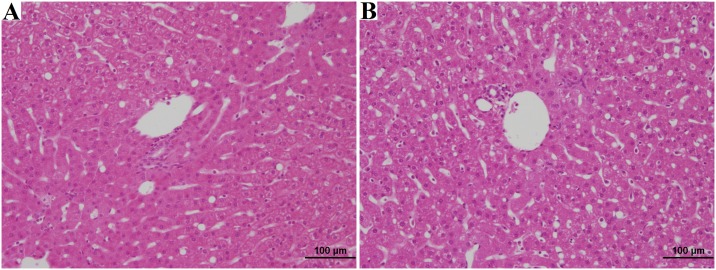
Liver H&E analysis.Biopsy A shows Liver H&E of naïve rhesus, age 15 years, diagnosed 5–10% macrovesicular fatty infiltrates, moderate/marked vacuolization. Biopsy B shows Liver H&E of brain dead rhesus, age 18 years, diagnosed 5–10% macrovesicular fatty infiltrates, moderate vacuolization.